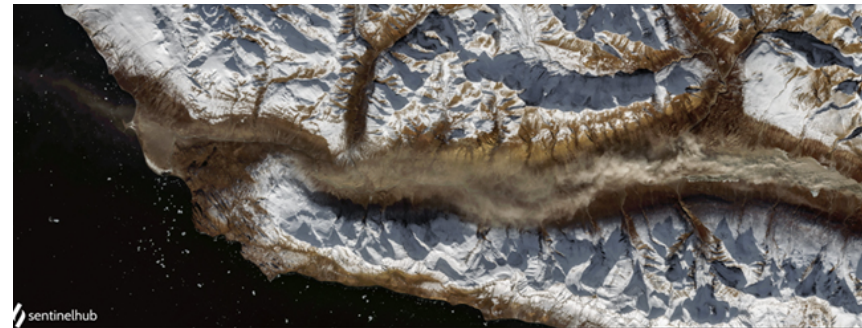
Figure 7. HLD storm on the Nuussuaq Peninsula, Greenland – 1 October 2020 (Markuse, 2020).